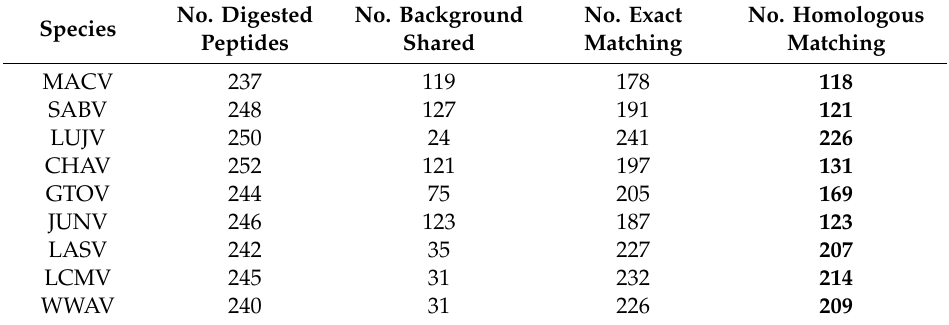
(i) in silico digest, (ii) exact matching, and (iii) homologous matching (80% background consensus threshold). Each target species was compared against the background of eight remaining arenavirus species proteomes. The second column provides the number of nonspecific peptides, i.e., the ones being shared with the background.